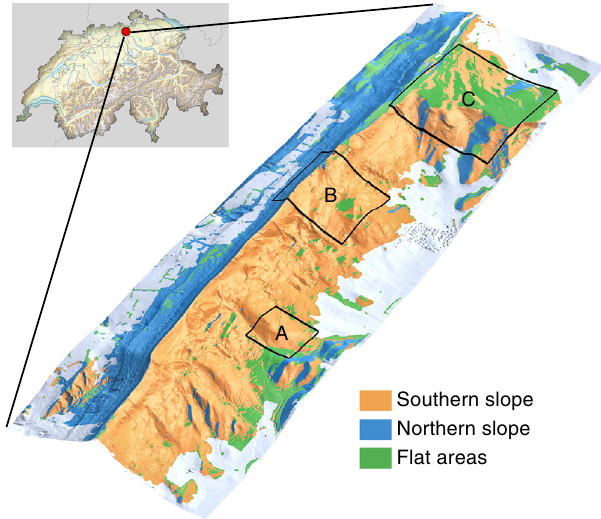
Fig. 1 Laegern mountain temperate mixed forest site in Switzerland. The test site is located near Zurich and covers about 2 × 6 km. The mountain range is divided by a ridge running from east to west, separating the forested area in north facing (blue) and south facing (orange) slopes. Flat areas are de fi ned with a slope < 10 ° (green). Areas not covered by forest (agriculture, grassland, urban areas) are shown in